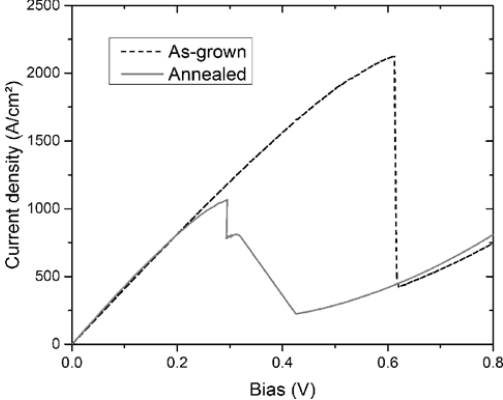
Figure 4. The J-V characteristics of an InGaP/GaAs (50 Å)/AlGaAs TJ, both as-grown and annealed for 30 min at 650 ◦ C for the low growth rate structure coupled with the early Te source shut-off